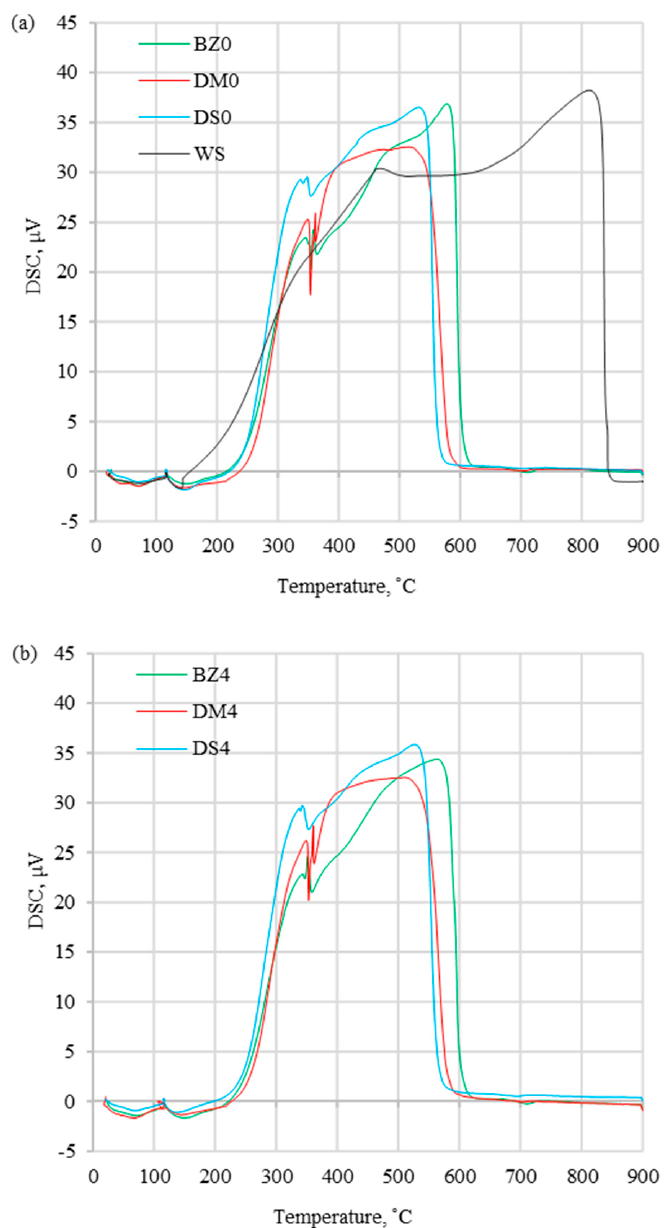
Figure 3. DSC curves for ( a ) fuels without halloysite and ( b ) fuels with halloysite at β = 20 °C/min.